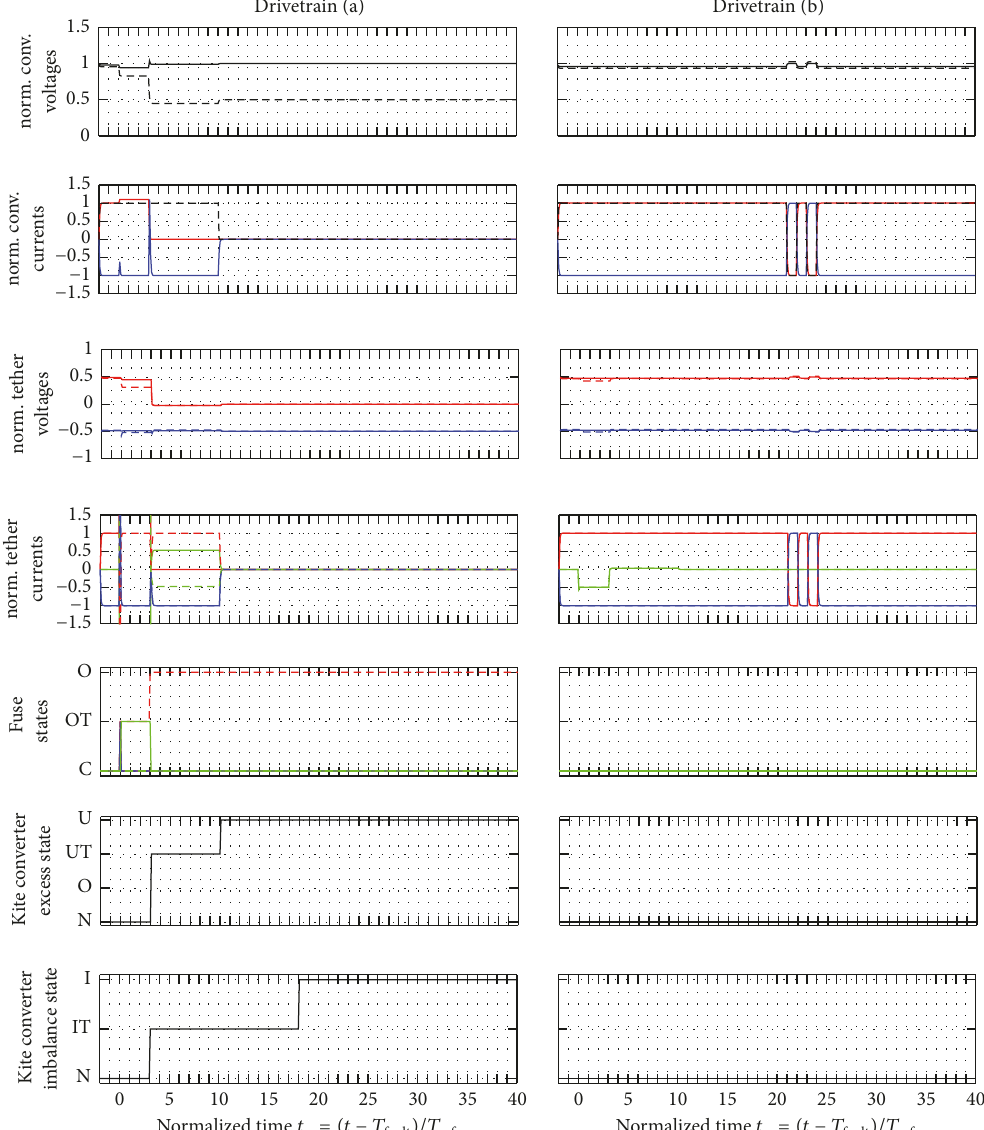
Figure 18: Simulated voltages, currents, and states for short circuit fault S2 in motor mode: (row 1) ground converter total voltage (solid), kite converter total voltage (dashed); (row 2) current of positive (red solid) and negative (blue solid) ground converter, current of kite converter (black dashed); (row 3) voltage of positive (red) and negative (blue) tether wire at ground in solid and at kite in dashed; (row 4) current in positive (red) and negative (blue) tether wire and in shield (green) at ground in solid and at kite in dashed; (row 5) state of fuse F1# (red solid), F2# (blue solid), F3# (red dashed), F4# (blue dashed ), F5# (green solid), and F6# (green dashed) with C for conducting, OT for conducting but overcurrent triggered, and O for open or overcurrent; (row 6) kite converter voltage excess state with N for normal, O for overvoltage, UT for undervoltage triggered, and U for undervoltage; and (row 7) kite converter voltage-imbalance state with N for normal, IT for imbalance triggered, and I for imbalance. All voltages are normalized for the rated voltage, all currents are normalized for the rated current of a drivetrain group, and the time is normalized 𝑡 for the reference time 𝑇 and shifted to the fault time 𝑇 . All voltages are with respect to the nearest n ref fault shield and the sign of all currents are counted “from left to right” in Figure